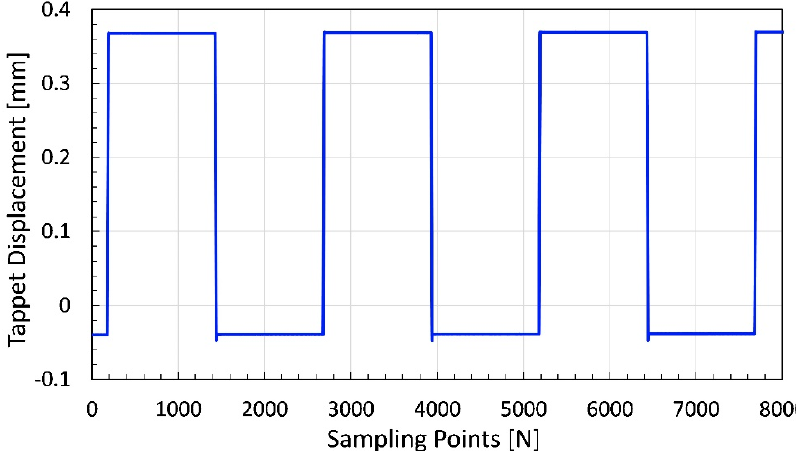
Figure 8. Tappet movement and displacement measurement result.